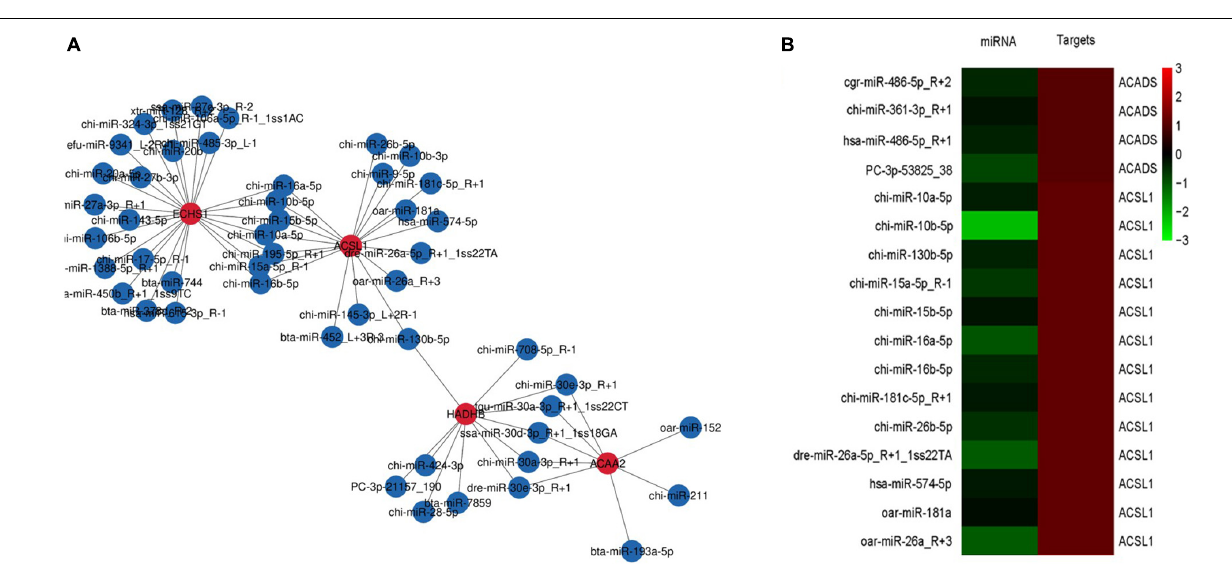
FIGURE 4 | mRNA-microRNA coregulation analysis (A) . miRNA-mRNA coregulatory network during fatty acid metabolism. The red and blue circles represent mRNAs and miRNAs, respectively. The solid lines indicate coregulation between miRNAs and mRNAs. (B) Clustering analysis of DEGs and miRNA expression